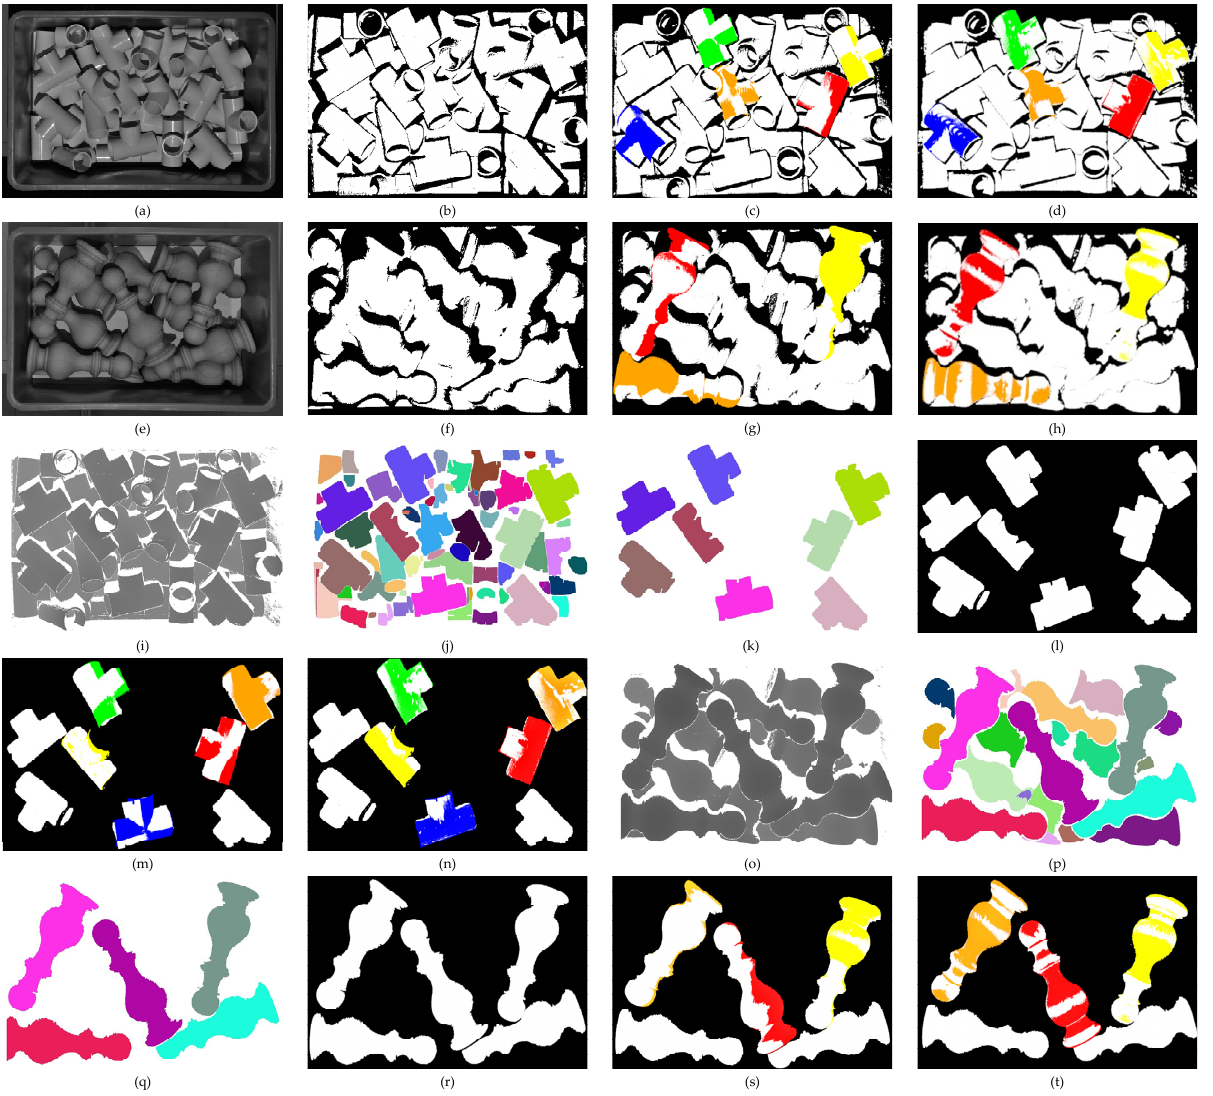
Figure 16. The matching process of the PPF algorithm and the Cur-PPF algorithm for two common objects in the industry. Among them, ( a ) is the three-way tube (the first type of objects); ( e ) is the upright column (the second type of objects); ( b , f ) correspond to the scene point cloud of two types of objects, the outer frame of the box is filtered out by setting thresholds on x − axis , y − axis respectively; ( c , g ) are matching results of the PPF algorithm for two types of objects; ( d , h ) are matching effect pictures after ICP correction; ( i , o ) are mapped from point cloud depth information to grayscale images; ( j , p ) are grayscale images after segmentation; ( k , q ) are candidate objects that are screened out according to the number of pixels in the segmented image; ( l ) and ( r ) are point clouds of candidate objects; ( m , s ) are the point cloud matching effect diagrams of the Cur-PPF al- gorithm; and ( n , t ) are matching effect pictures after ICP correction. The matching rate from high to low is rendered in the order of red, orange, yellow, green, and blue. Table 6. The matching rate of PPF and Cur-PPF algorithms on real data sets. Models